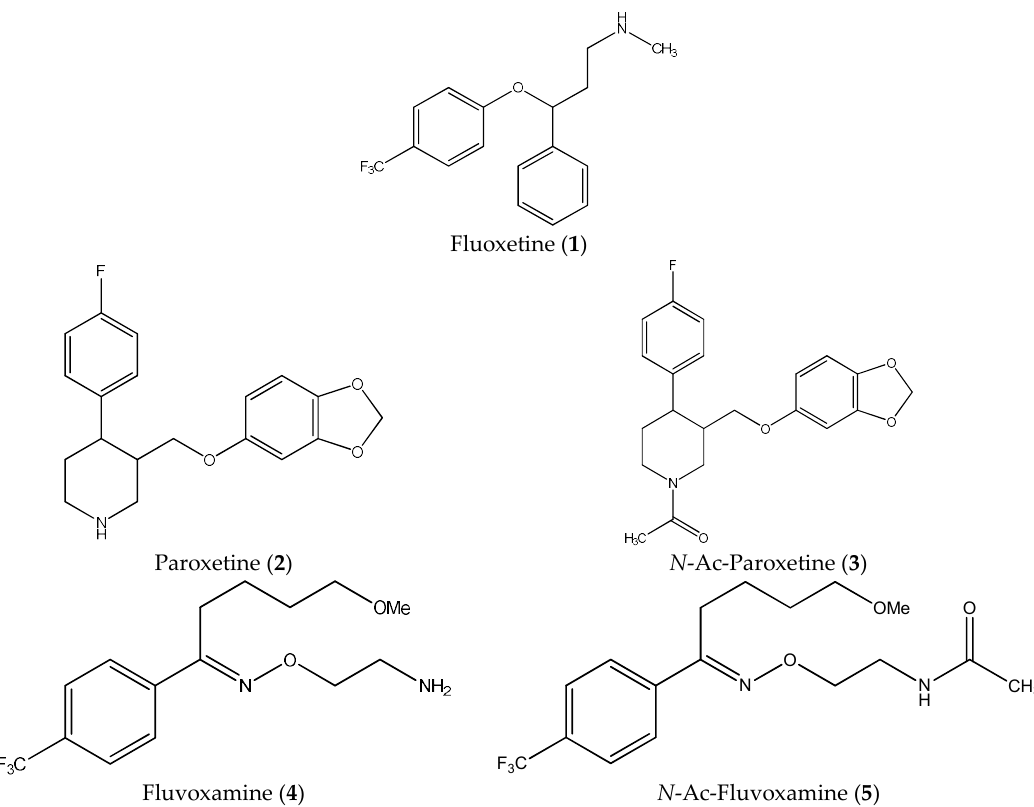
Figure 1. Structures of fluoxetine ( 1 ), paroxetine ( 2 ), fluvoxamine ( 4 ) and acetylated derivatives of paroxetine ( 3 ) and fluvoxamine ( 5 ).